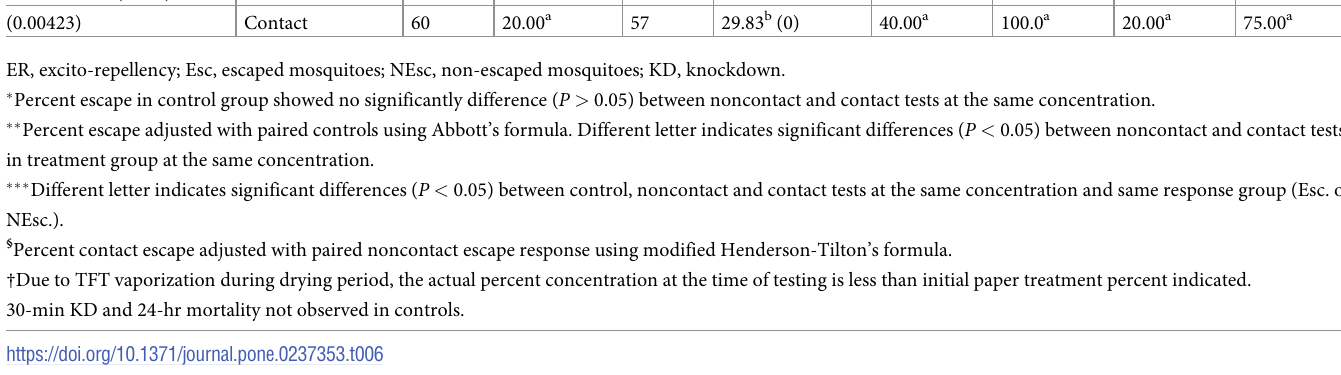
Table 6. Mean percent escape response and percent mortality of Ae . aegypti and An . harrisoni field populations exposed to LC 50 TFT. Species ER